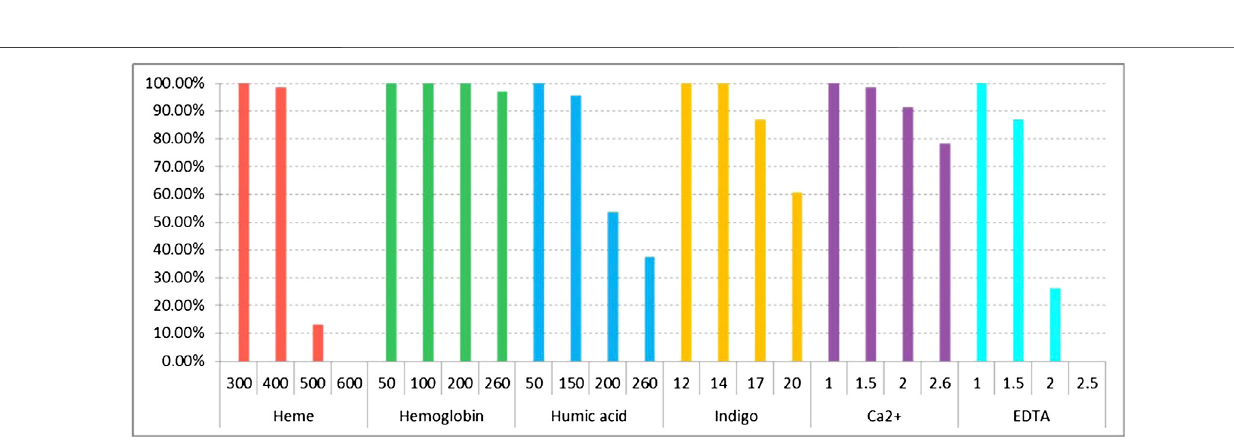
FIGURE4| Detectionratiosof32RMY-STRsinthepresenceofdifferentconcentrationsofPCRinhibitorsheme,hemoglobin,humicacid,indigo,Ca 2+ ,andEDTA by the HomyGene RM Y32